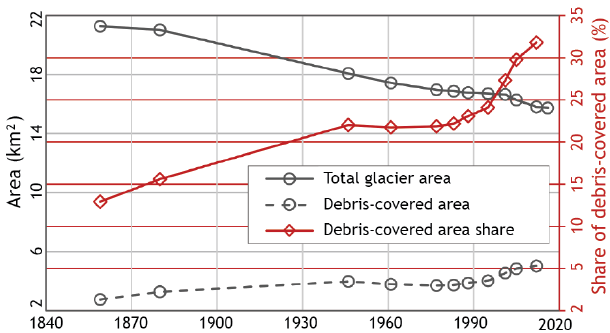
Figure 5. Evolution of total glacier area, debris-covered glacier area, and the share of the debris-covered glacier area.